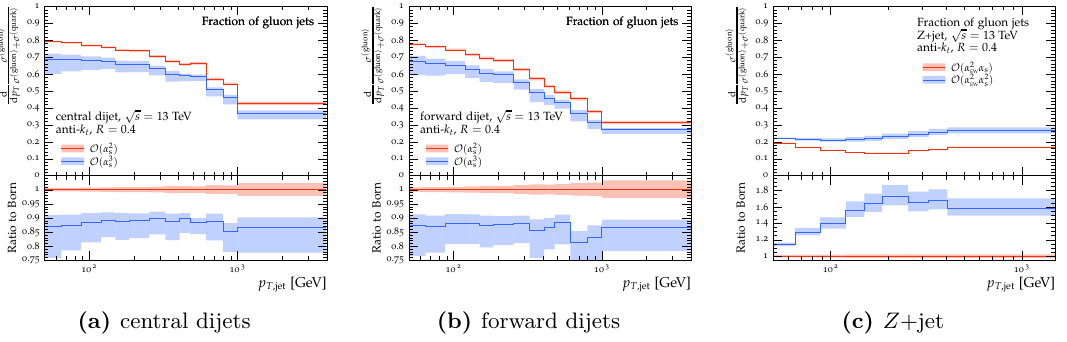
Figure 6. Fraction of gluon jets as a function of the jet transverse momentum p T, jet in dijet (left and middle) and Z +jet (right) processes. For the dijet production we present results for the leading central and forward jet, respectively. We show predictions at Born (red bands) and at one-loop level (blue bands). Flavour tagging for the considered anti- k t jets relies on the algorithm described in [51], that employs the BSZ flavour- k t algorithm, and in turn defines the partonic channels δ in our implementation of NLL C AESAR resummation in S HERPA